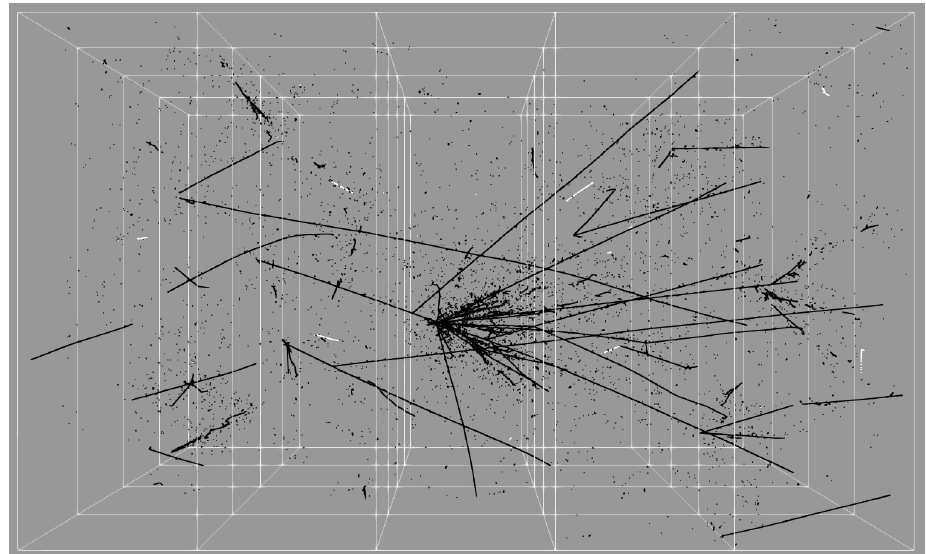
Figure 24. A beam spill in ND-LAr. Fast-neutron induced recoiling proton tracks, with an energy threshold greater than 10MeV, are shown in white. The black tracks are all other energy deposits ∼ sufficient to cause charge collected at the pixel planes.